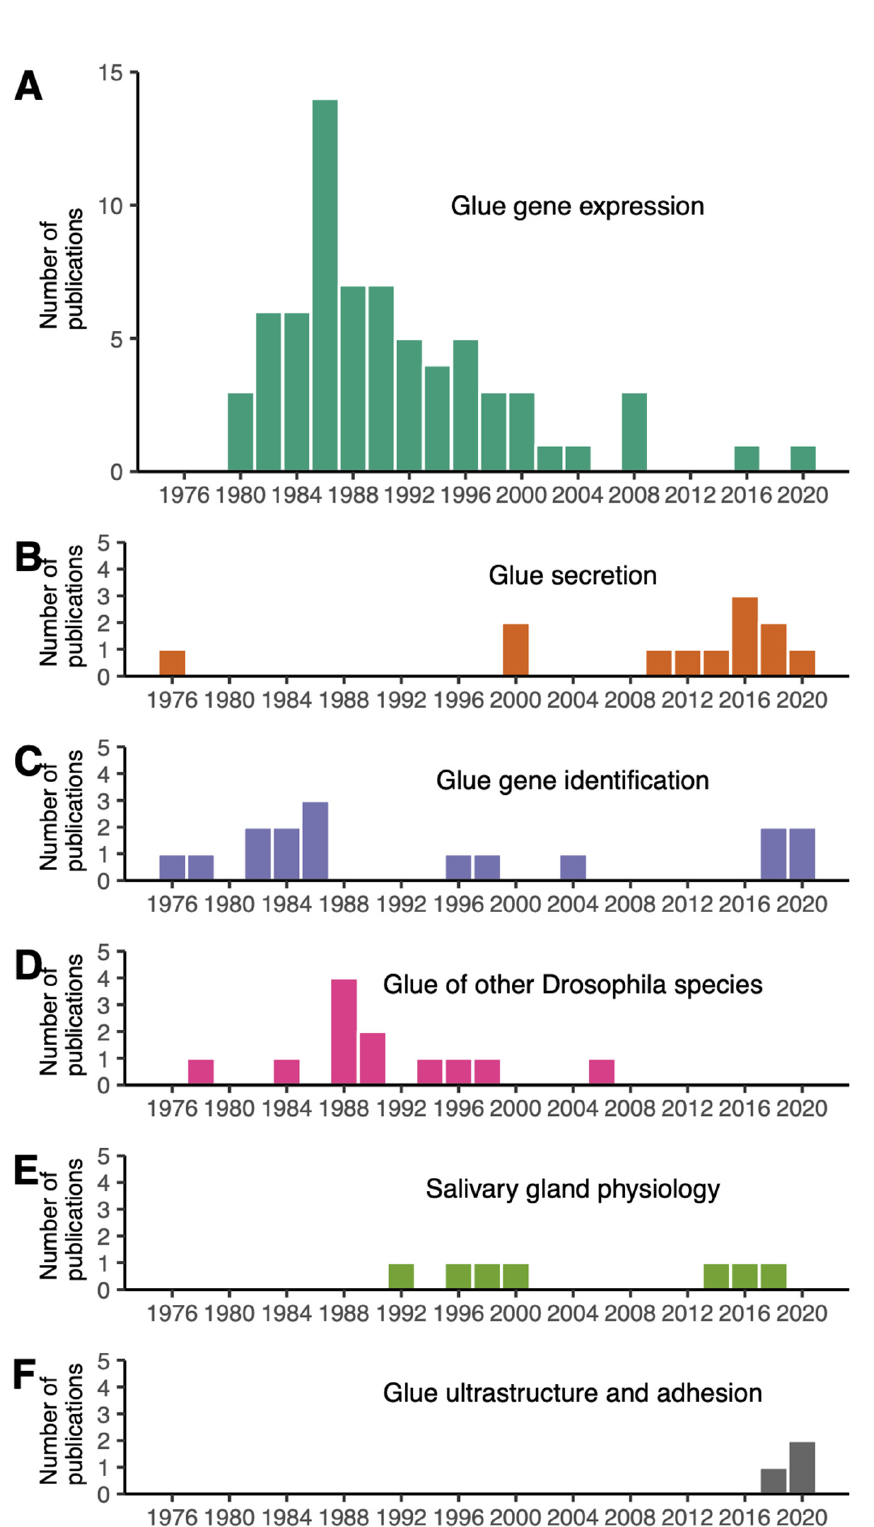
Figure 1. Distribution of Drosophila glue papers by year of publication and research topic. Five research topics are distinguished: ( A ) glue gene expression (70 articles), ( B ) glue gene identification (15 articles), ( C ) glue secretion (12 articles), ( D ) glue of other Drosophila species (12 articles), ( E ) salivary gland physiology (7 articles), ( F ) glue ultrastructure and adhesion (3 articles).